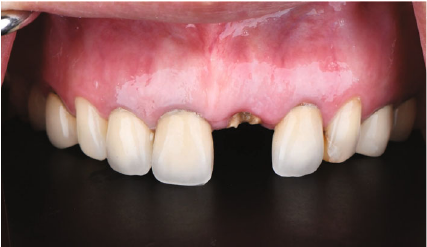
Figure 1: Pretreatment clinical photograph showing the fracture of tooth number 21 almost below the cementoenamel junction with no ferrule e ff